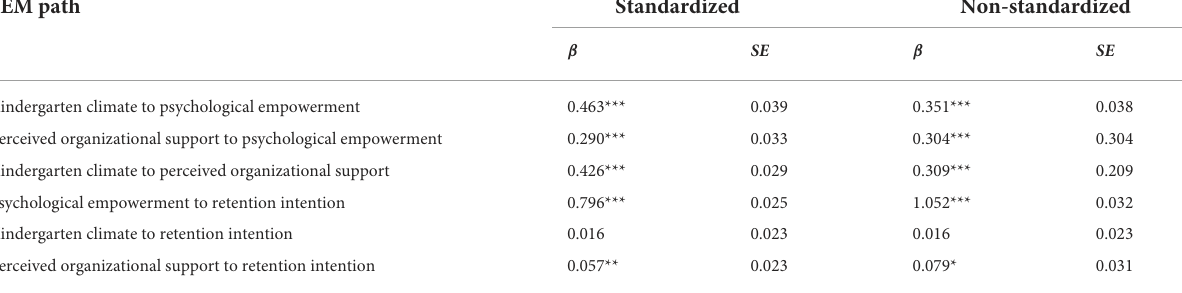
TABLE 2 SEM path